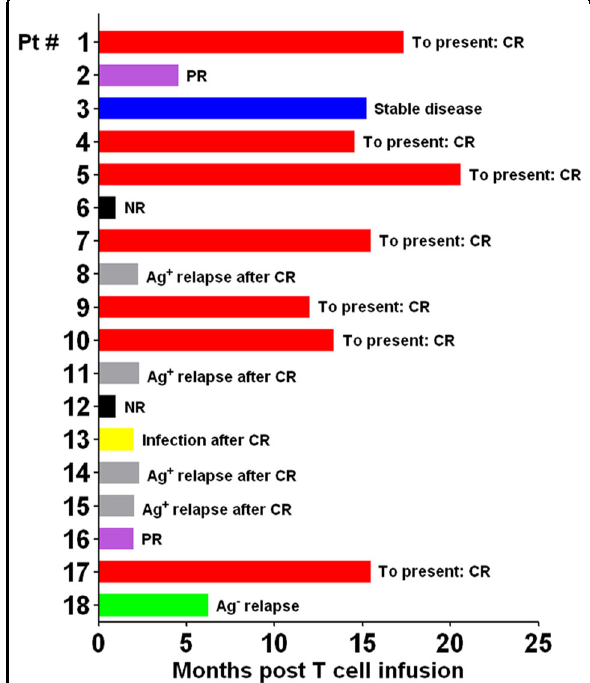
Fig. 5 Long term survival of patients (as numbered in Table 1) treated with CART-aIL6/IL1RA. Patients with refractory or relapsed ALL, CLL, Lymphoma or MM were enrolled and treated with anti-CD19 or anti-BCMA CART secreting anti-IL6 scFv and IL1RA. After CART infusion, patients were examined for clinical response of tumor remission, and followed up for evaluating long-term survival. CR complete response, PR partial response, NR no response, Ag + relapse antigen positive relapse, Ag – relapse antigen negative